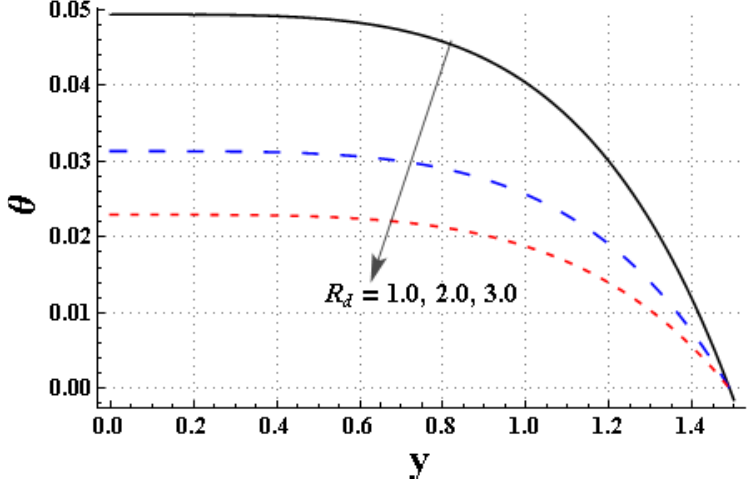
R Figure 7. Effect of R d on temperature, θ . Figure 7. Effect of d on temperature,  .